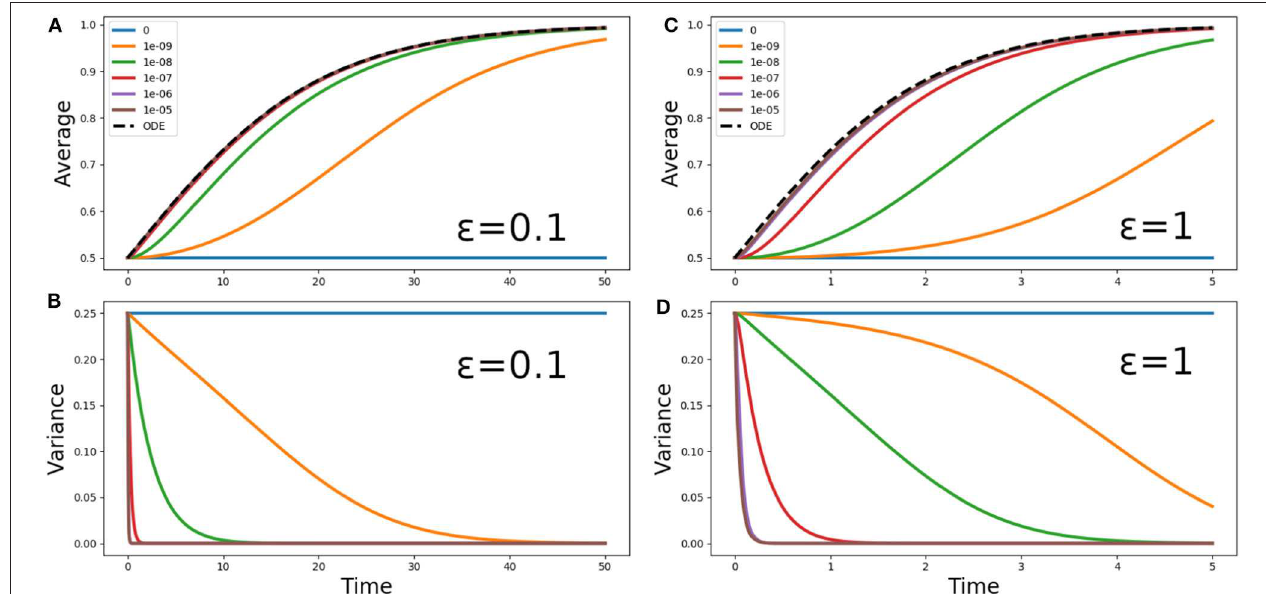
FIGURE 3 | (A,C) Average phytoplankton concentration and (B,D) variance, as a function of time, for the problem (5) with f ( z ) = 1, ε = 0.1 (A,B) or ε = 1 (C,D) and the step initial condition (2). The solid lines refer to Lagrangian aquacosm simulations with varying strength of the coupling parameter p . The dashed line is the solution of the Sverdrup’s approximation (18). Note the different ranges of the time axes.